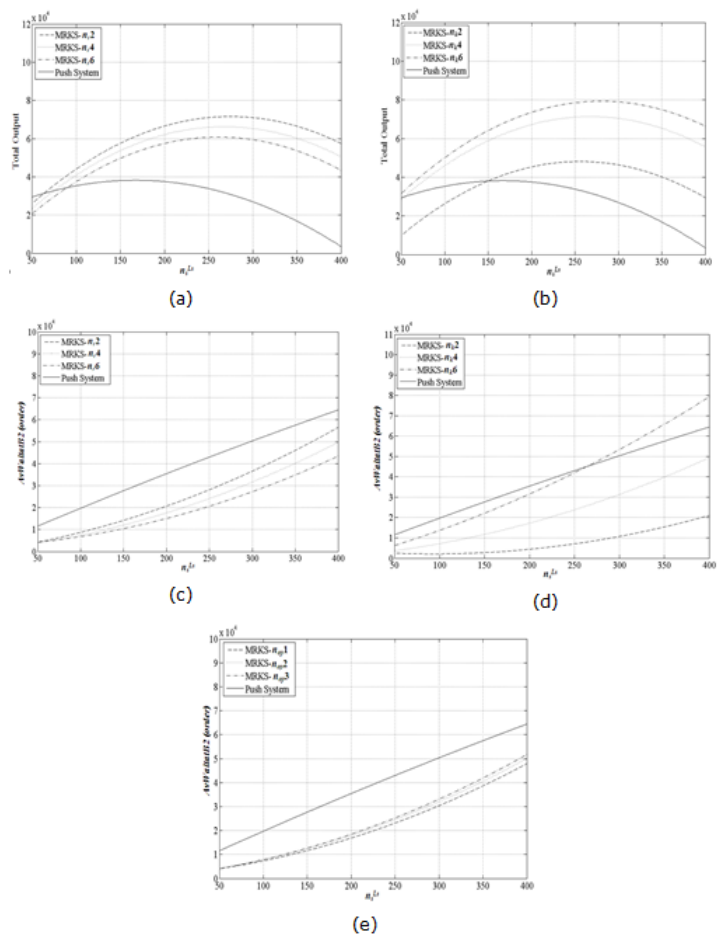
Figure 17. Effect of n sLs on total output and